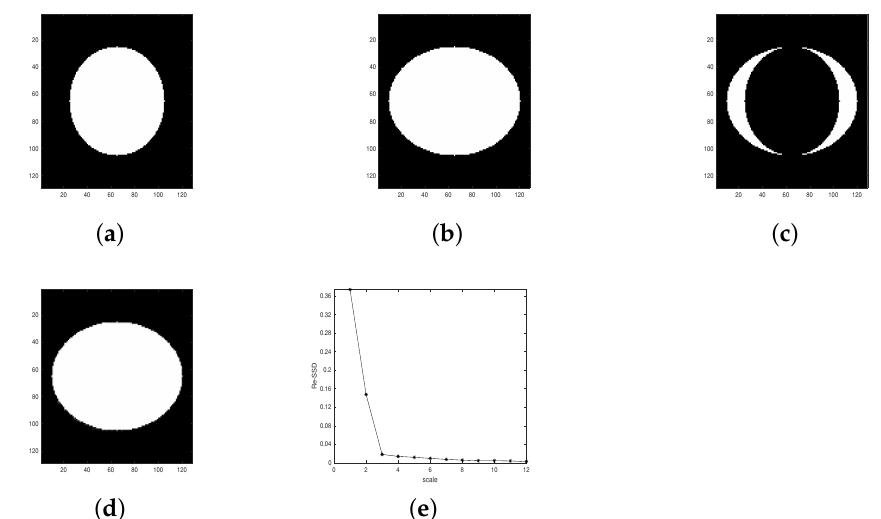
Figure 3. Registration result of Algorithm 2 on image pairs C-E. ( a ) T ( · ) . ( b ) D ( · ) . ( c ) | T − D | . ( · ) . ( e ) Re − SSD change (C-E) with scale number. ( d ) T ◦ ˆ h K M